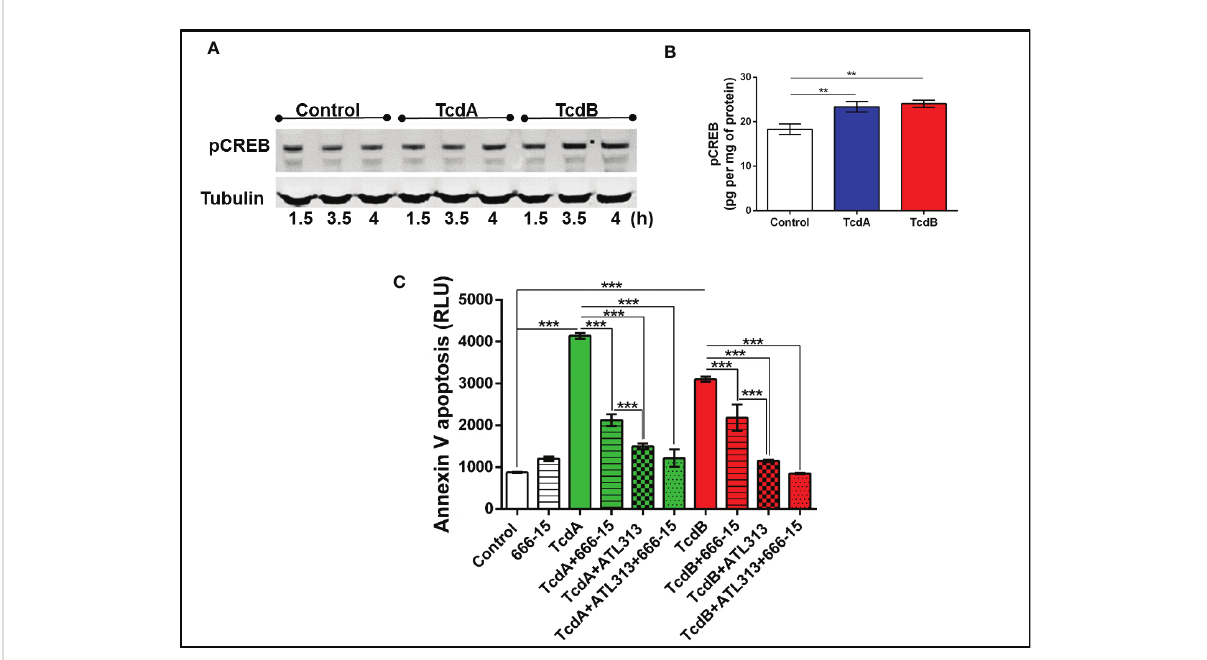
FIGURE 5 C. dif fi cile toxins increases the levels of phosphorylated CREB, which are involved in EGCs death induced by these toxins in vitro . (A) Representative Western Blot images showing phosphorylated CREB and tubulin (loading control) protein expression. (B) levels of pCREB (mean ± s.e.m.) measured by ELISA in EGCs challenged with TcdA and TcdB for 4h. (C) Cell death analyzed by RealTime-Glo annexin V apoptosis assay (mean ± s.e.m, n=6) in enteroglial cell (EGC/PK060399) challenged with TcdA and TcdB for 18 h in the presence and/or absence of 0.5 µM 666-15 (a CREB inhibitor) and 300 µM ATL313 (an A2a-selective adenosine receptor agonist), added one hour prior to C . dif fi cile toxin challenge. (B, C) One-way ANOVA followed by Turkey test was used. These experiments are from two different replicates. ***p<0.0001,